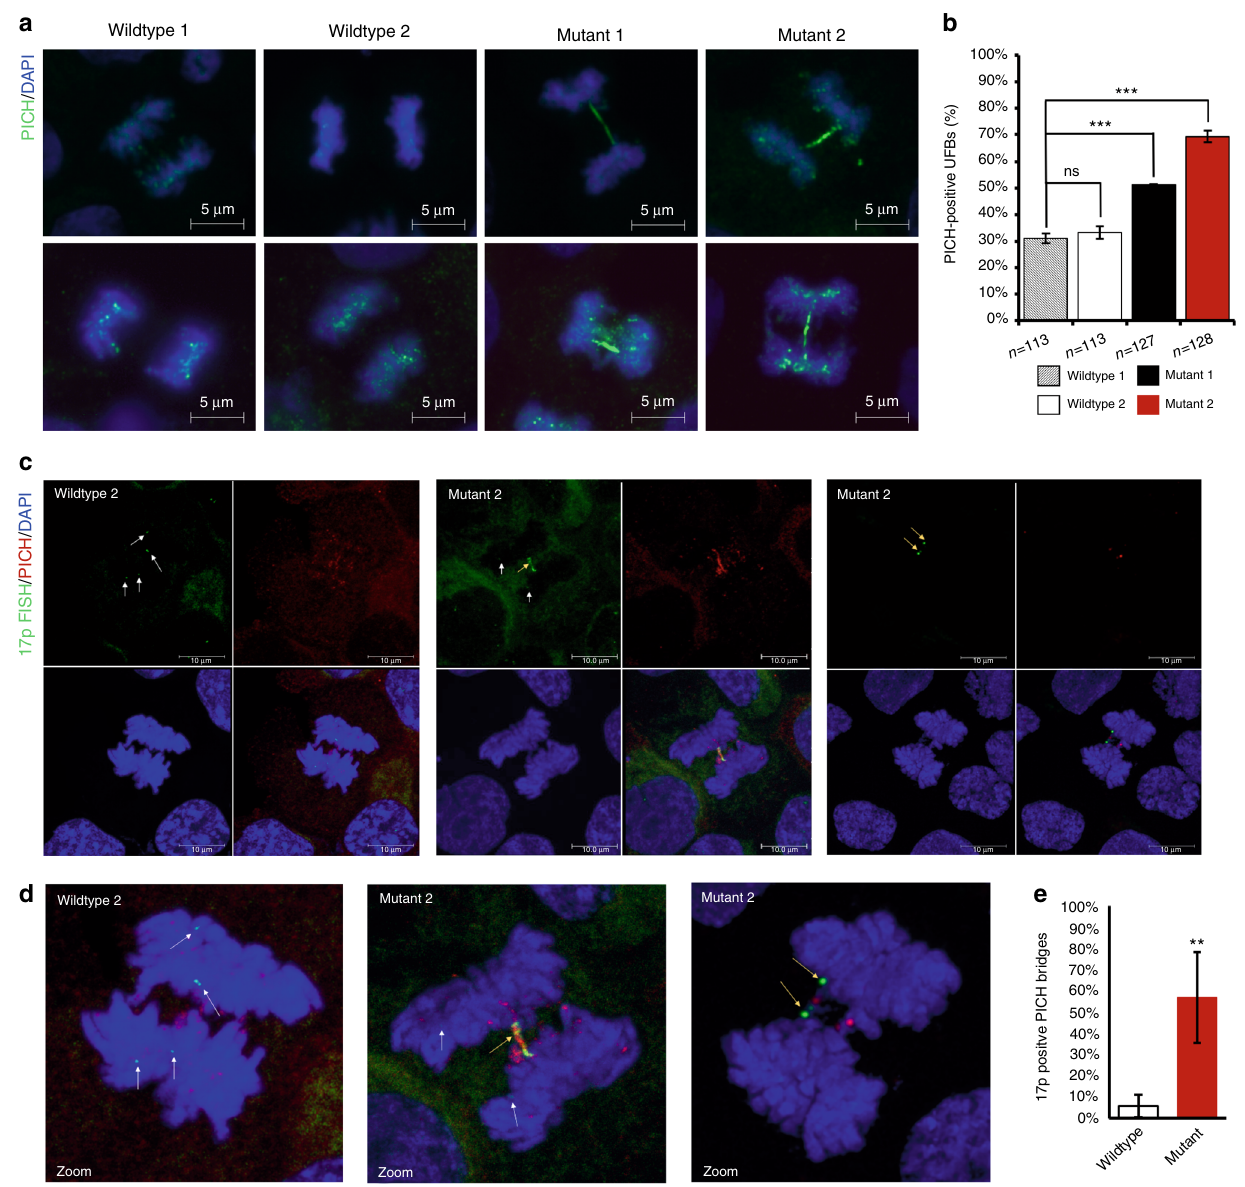
Fig. 4 CTCF site mutant 17p telomere ends form ultra- fi ne anaphase bridges (UFBs). a Cells were synchronized by thymidine block and collected between 8 – 9 h post release and stained with PICH (green) to detect ultra- fi ne bridges in anaphase cells. b Quanti fi cation of a . c Cells were treated as in b and co- stained for PICH protein and 17p chromosome FISH. Representative image of anaphase bridges for wildtype and Mutant 2. White arrows indicate unaffected 17p FISH signals; yellow arrows indicate 17p FISH signals co-localizing with PICH-positive UFBs. d zoomed fi elds of merged images in c . e Quanti fi cation of c . IF/FISH experiments represent average of three biological replicates and SEM; ** p < 0.01; *** p < 0.001, measured by Student's t